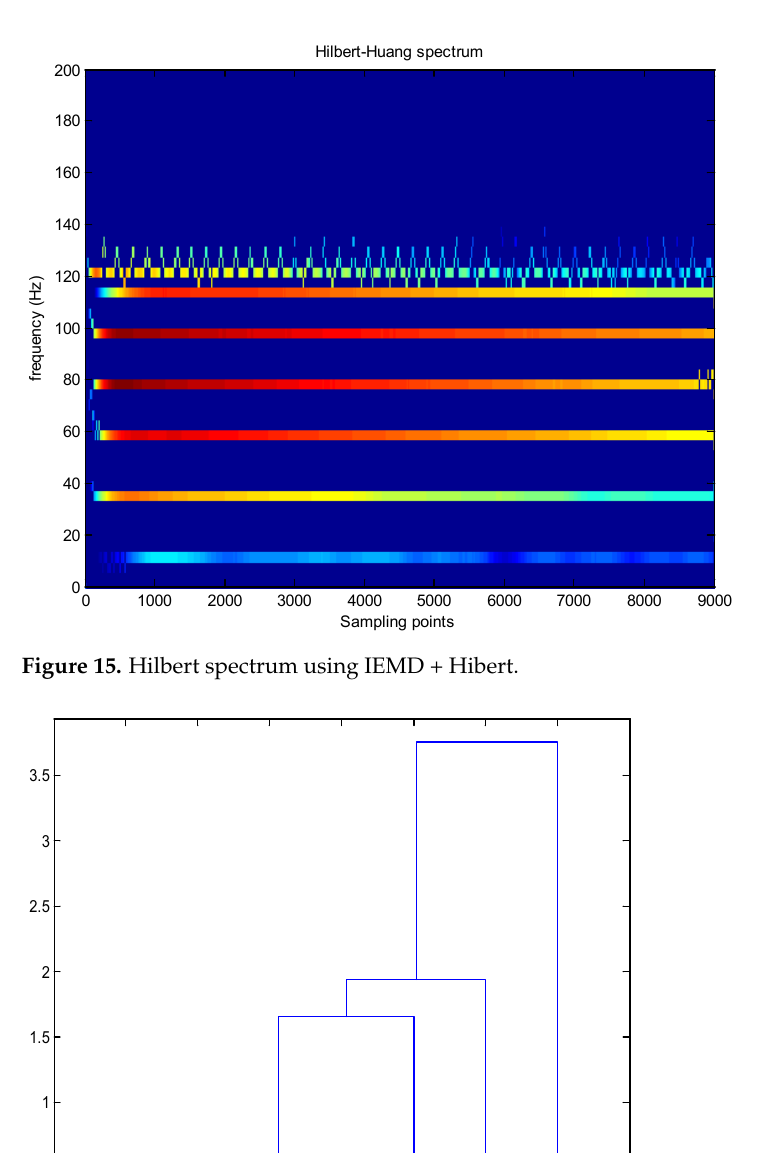
Figure 14. Acceleration signal and IMF1−7 using EMD.